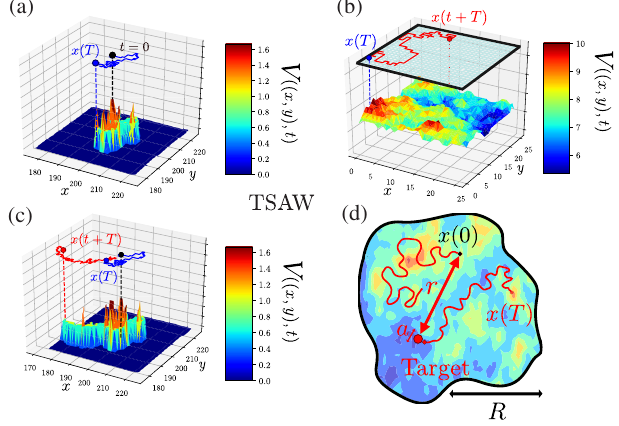
FIG. 1. Aging and first-passage times for self-interacting random walks in infinite space and in confined domains. Examples of 2 d self-interacting trajectories (TSAW model, see text): In panel (a), the random path from t ¼ 0 to T generates the local energy landscape V ðð x; y Þ ; t Þ [proportional to the total number of visits to ð x; y Þ until t ], plotted along the vertical axis z . This dynamics can lead to long-range memory effects and aging at all timescales. The trajectory after T plotted in panel (c) explicitly depends on the full territory visited by the walker until T . In confined domains (b), the statistics of visits to a given site is radically modified by confinement. The dynamics of self- interacting random walks is thus geometry dependent. In panel (d), we aim at quantifying space exploration and search kinetics of confined self-interacting random